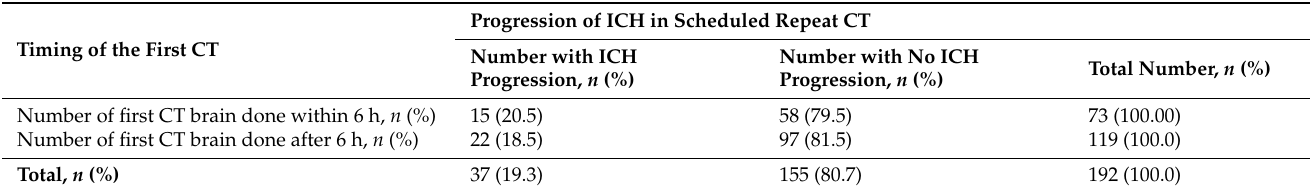
Table 4. Timing of the first CT brain in relation to ICH progression in scheduled repeat CT